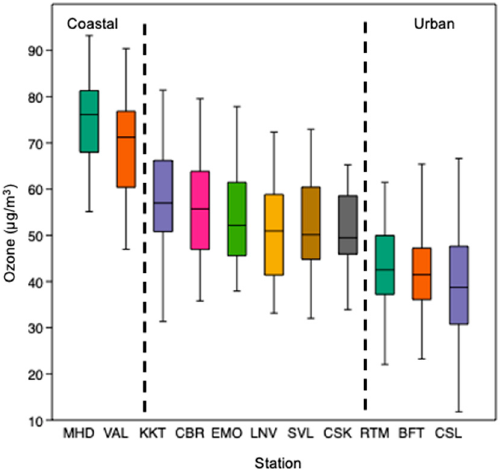
Figure 2. Box plots displaying monthly mean ozone concentrations ( µ g/m 3 ) for the monitoring stations based on the period 2015–2019 (dashed lines separate Atlantic coastal from rural–sub-urban, and urban). The median, 95-, 75-, 50-, 25-, and 5-percentiles ordered from highest to lowest medians are presented (see Table 1 for station ID codes).